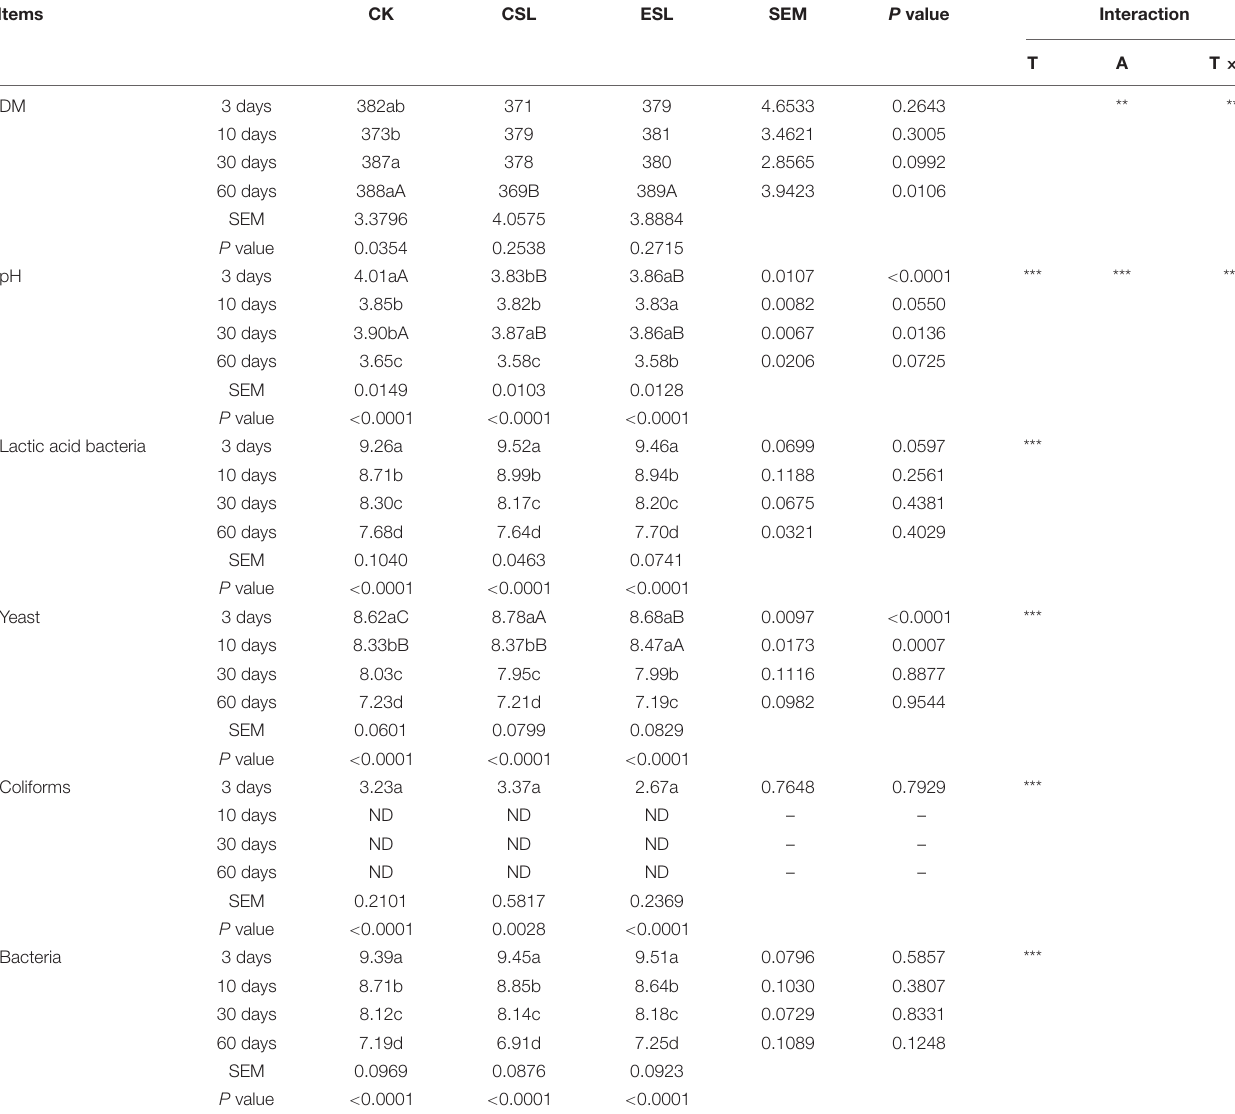
TABLE 4 | Dry matter (DM, g/kg) and microbial counts (log 10 colony-forming units/g fresh weight) of whole-plant corn silage during the stable phase. Items CK CSL SEM P value